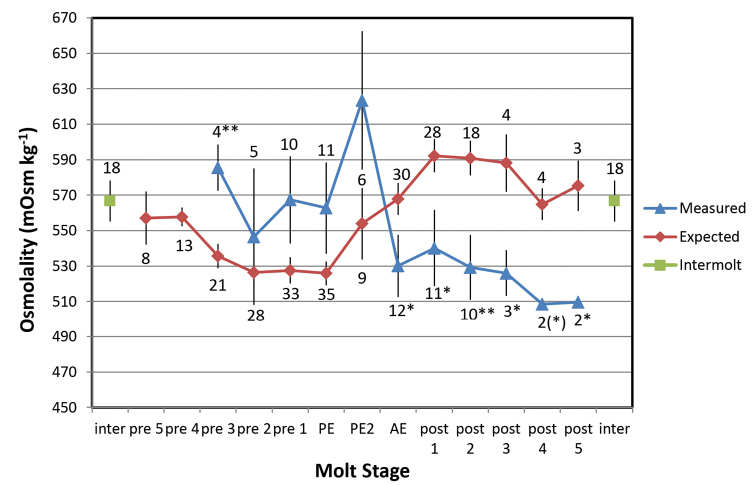
Mean measured (blue) and expected (red) values for hemolymph osmolality in Armadillidiumvulgare during molting in 100 % RH. Expected values are derived from the product of the mean intermolt osmolality (green symbols) and the proportional changes in blood volume over the molt cycle (see text). Bars show ± 1 SEM with sample sizes. Molt stages as in Figs 1–4. Asterisks denote significant differences between measured and expected means (2-sample t-test). * P < 0.05; ** P < 0.01. (*) P = 0.056.